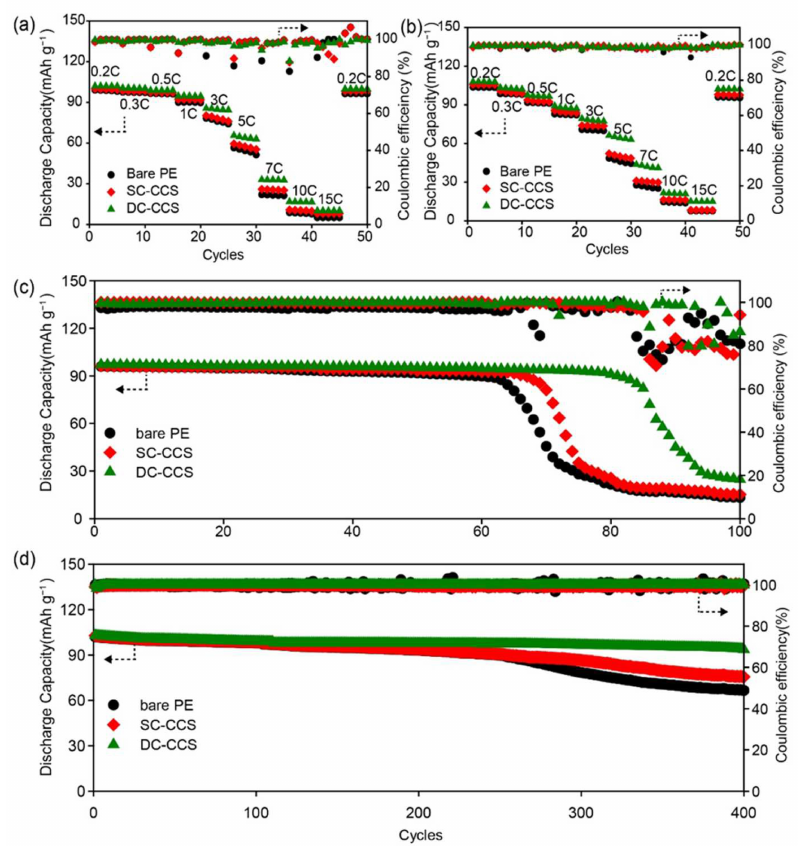
Figure 7. Rate capability of CR2032-type ( a ) half cells (LMO/Li metal) and ( b ) full cells (LMO/graphite) (discharging rate was varied while maintaining the charging rate of C/5 = 0.257 mA cm − 2 ) with the Coulombic efficiencies. Cycle performance of CR2032-type ( c ) half cells (LMO/Li metal) and ( d ) full cells (LMO/graphite) (charging and discharging rates = 1.283 mA cm − 2 ) with the Coulombic